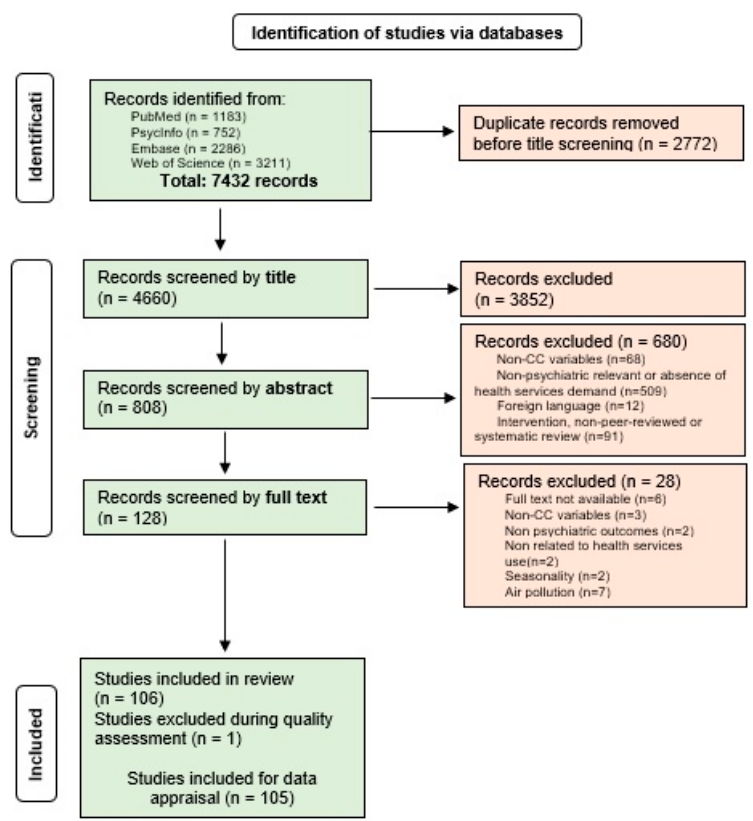
Figure 1. PRISMA diagram for Systematic Literature Reviews [28]. Table 2. General characteristics of all the included studies. * Weather variables included: snow and rain, temperature variability, temperature change between neighboring days, and daily excess hourly heat. The order studies were placed in the table was, as follows: MH in general or multiple types of disorders and, then, the sequence of specific ICD-10th, from F00 to F99. Mortality and sui- cide were placed next. Lastly, the extreme event-related outcomes.